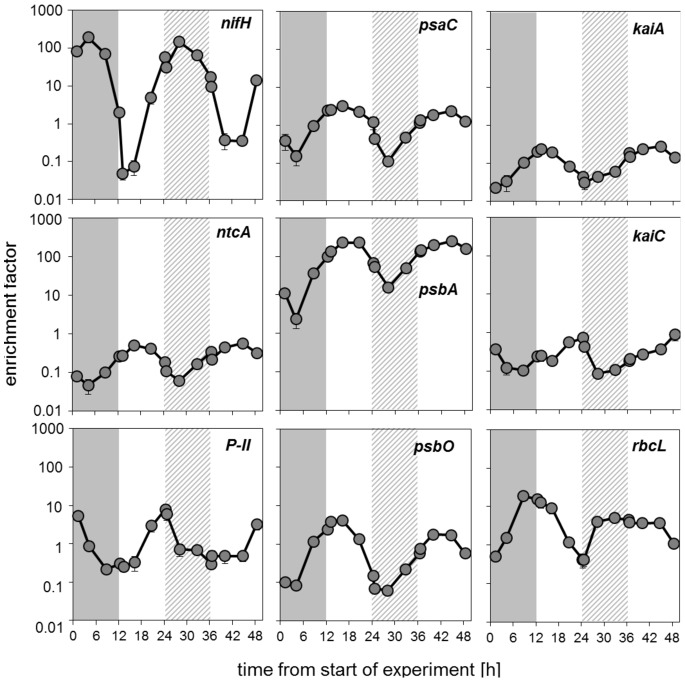
Gene expression analysis shown as enrichment factor of relative transcript abundance.The genes are indicated in the top right corner of each panel. Filled circles represent the experimental data during the 48 h phase. The grey bars indicate the regular dark phase and the striped grey bars indicate the subjective dark phase. Symbols and error bars represent mean ± SE of triplicate cultures.